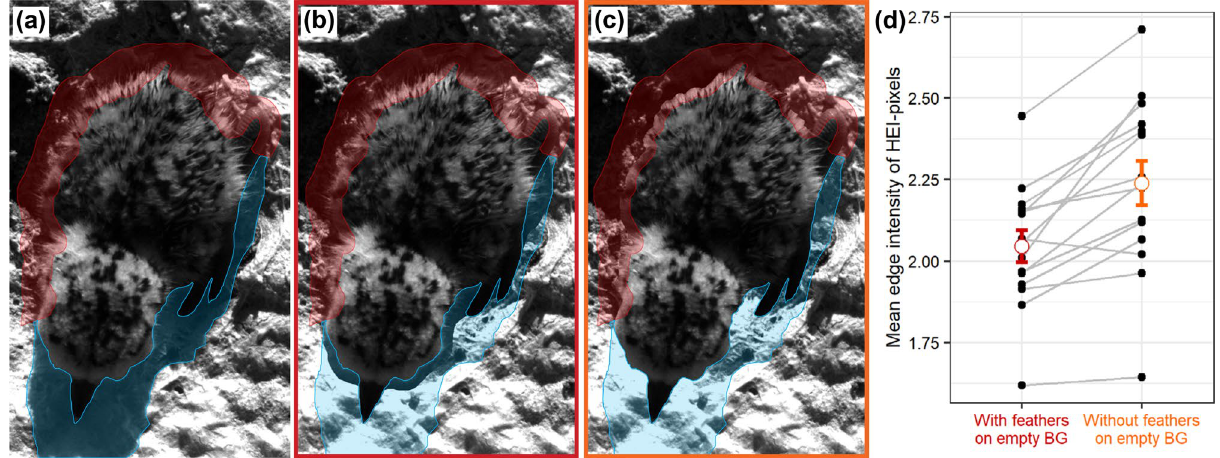
Figure 2. (a) A snowy plover chick hiding on the ground from an approaching predator, (b) cropped chick transferred to image of empty natural background with neoptile contour feathers protruding the outline, (c) cropped chick transferred without protruding neoptile contour feathers. The contour region (red) as the region of interest was analysed in the Local Edge Intensity Analysis (LEIA). Areas, where the background was shaded by the chick in the original image (blue), were excluded from the analysis. (d) Mean edge intensity of the HEI pixels in the contour region with and without feathers for 15 snowy plover chicks (t = 5.289, df = 14, p-value < 0.001). Measurements are paired by chick ID. The error bars indicate group mean ± standard error. The figure was produced using R 28 Adobe Photoshop 29 and InDesign 30